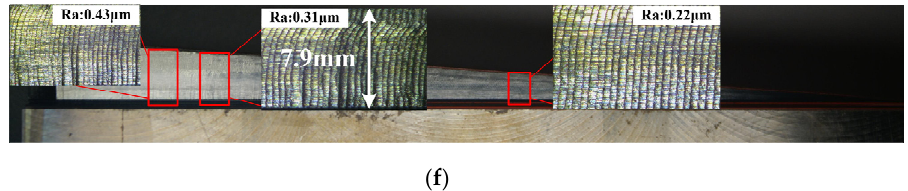
Figure 7. Experimental results of industrial cases; ( a – c ) is measured chatter stability, acceleration signal and its FFT spectrum, and machined surface topography when variable pitch tool (tool 2) is used in the experiments; ( d – f ) is measured chatter stability, acceleration signal and its FFT spectrum, and machined surface topography when anti-vibration tool (tool 3) is used.